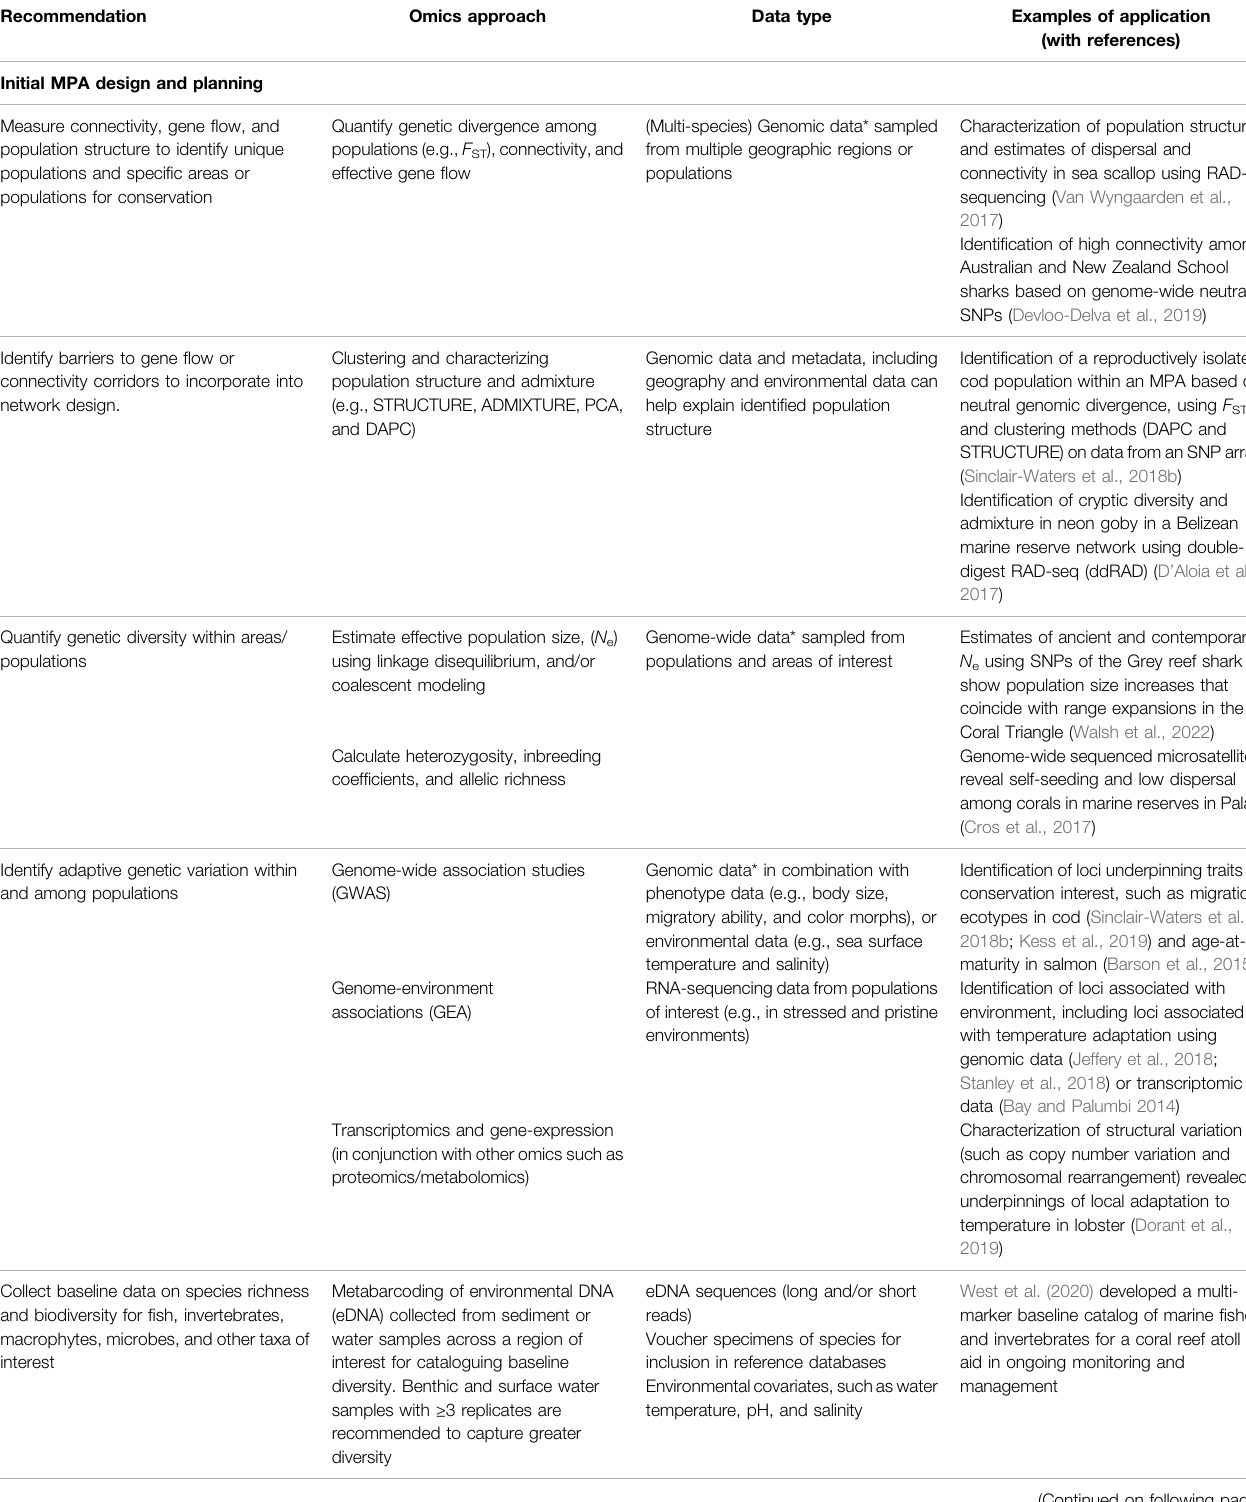
TABLE 1 | Examples of molecular omics tools and their applications in various stages of MPA design and management, including baseline data acquisition, network design toincorporategeneticdiversityandconnectivity,andmonitoringMPAs.Recommendationsforwhichmethodsortoolstouseareprovided,withexamplereferences.We note that this does not represent an exhaustive list of methods and applications, but can be used to guide the process of MPA design and